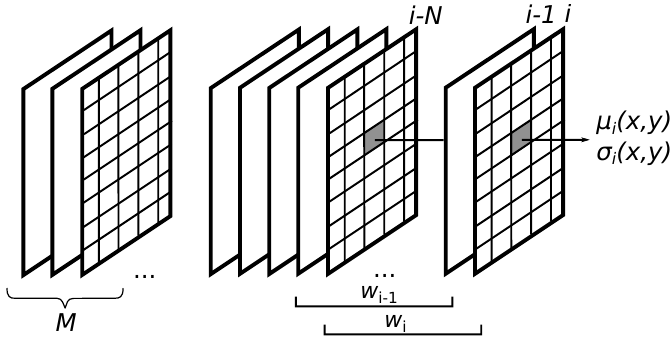
Figure 6. Idea of time-domain single pixel